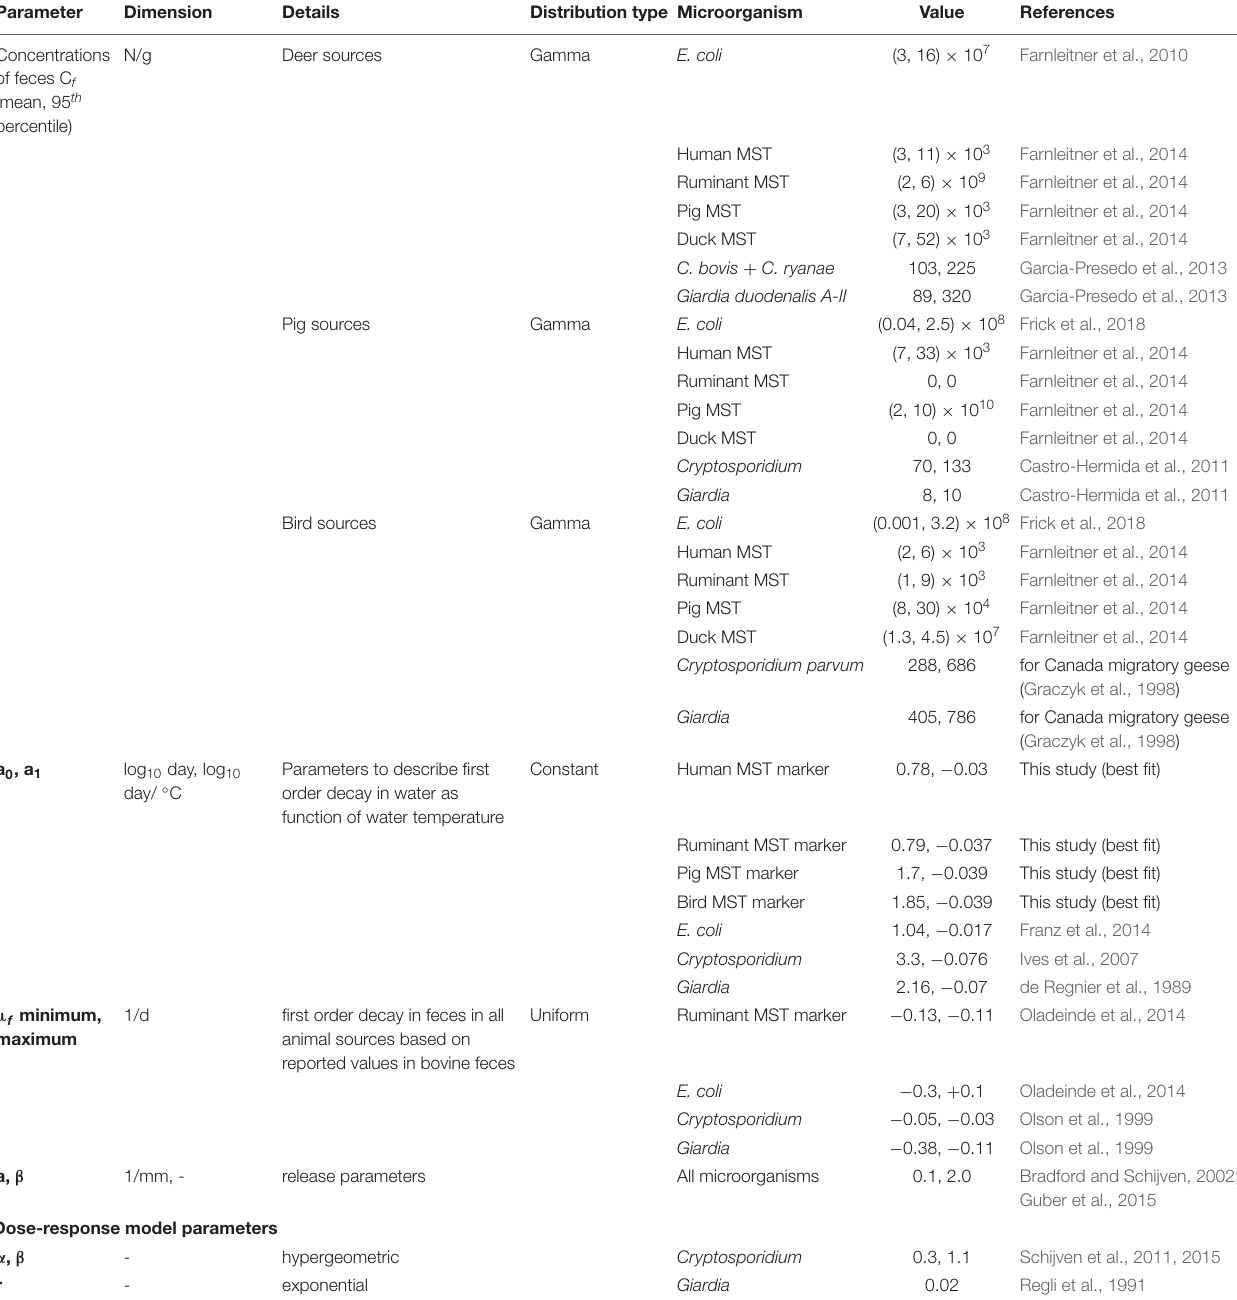
TABLE 1 | Microorganism-specific model input parameters in